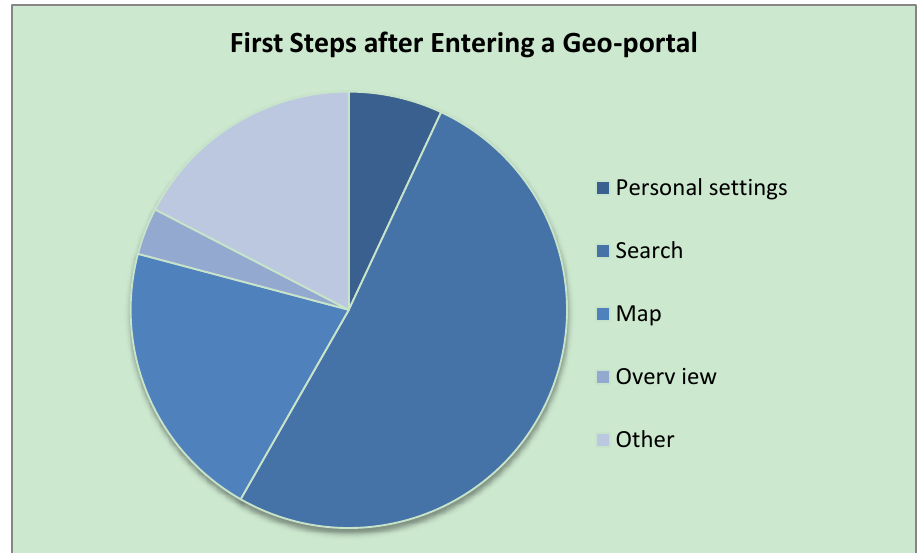
Figure 2. First Steps after Entering a